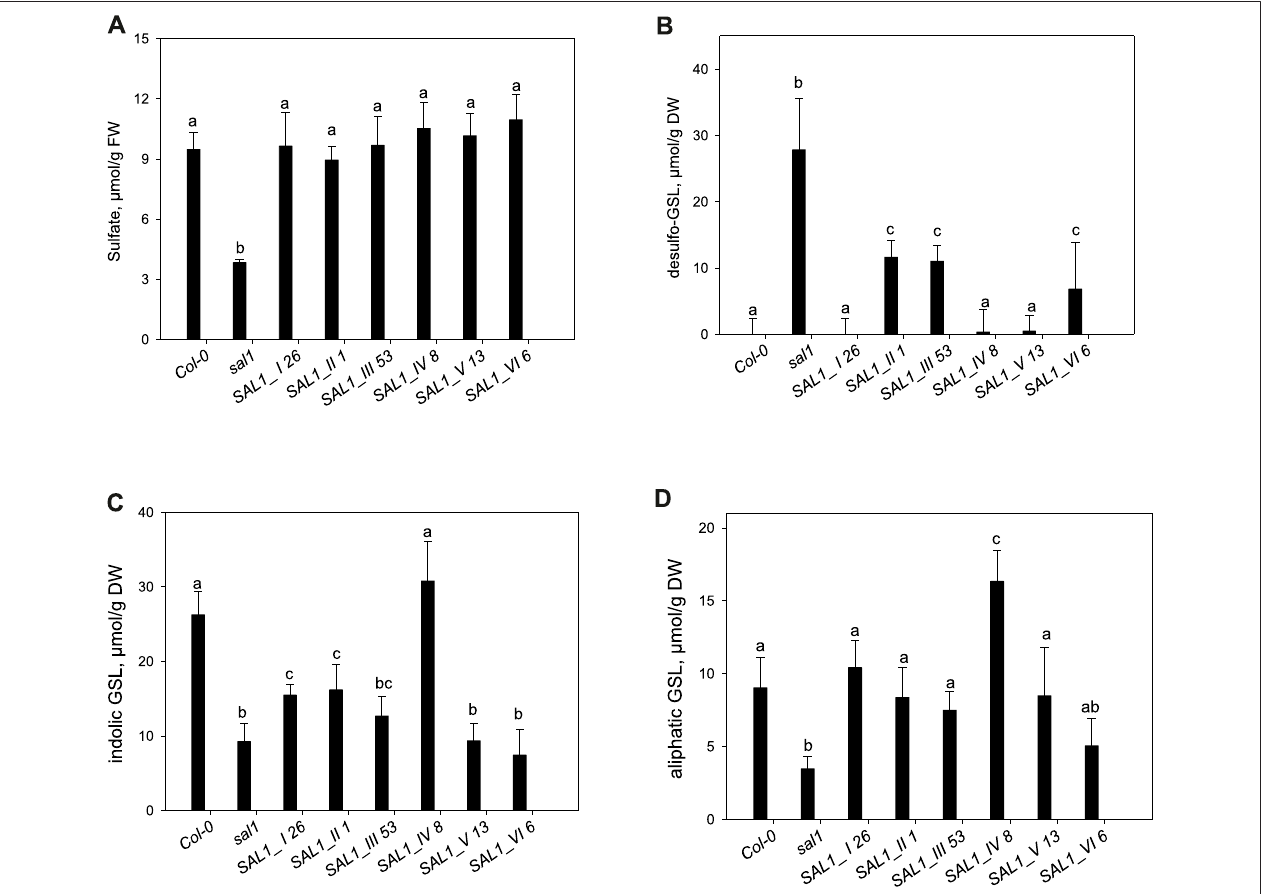
FIGURE 6 | Analysis of sulfate, desulfo-glucosinolate (GSL), and aliphatic and indolic GSL levels in complemented sal1 mutant lines. The levels of sulfate (A) , desulfo-GSL (B) , indolic GSL (C) , and aliphatic GSL (D) were analyzed in rosette leaves of 5-week-old sal1 and complemented lines SAL1_I 26 , SAL1_II 1 , SAL1_III 53 , SAL1_IV 8 , SAL1_V 13 , and SAL1_VI 6. Sulfur metabolites of partially complemented lines are shown in Supplementary Figure S3 . Plants were grown on soil in short days in an environment-controlled chamber. Data show the mean ± SD ( n (cid:1) 4). FW , fresh weight. Different letters indicate signi fi cant differences among means based on t -tests at p <